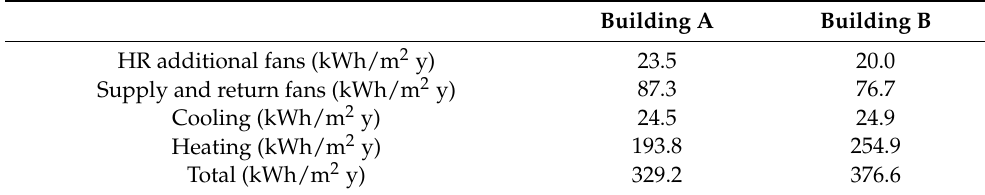
Table 3. Comparison of the primary energy composition for the two buildings for control strategy